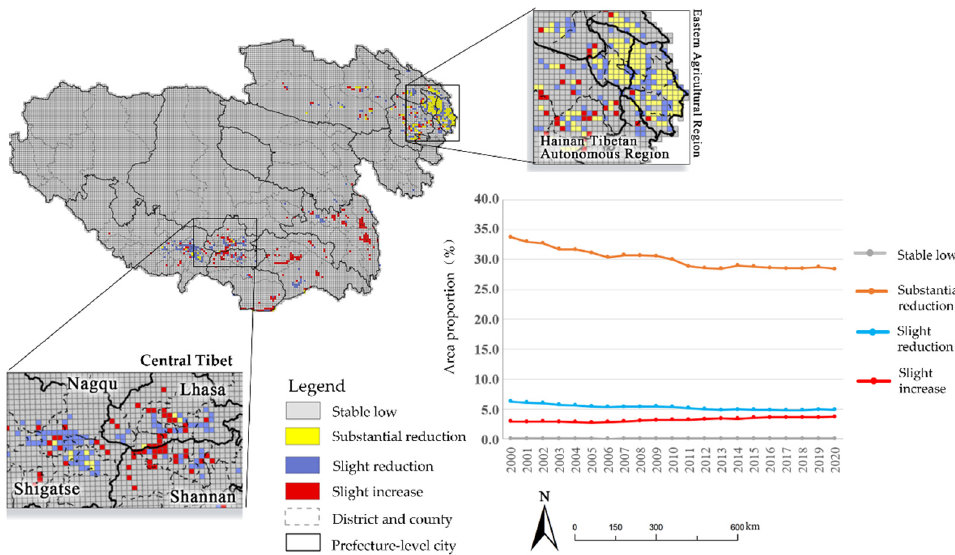
Figure 4. The evolution of the agricultural pattern.